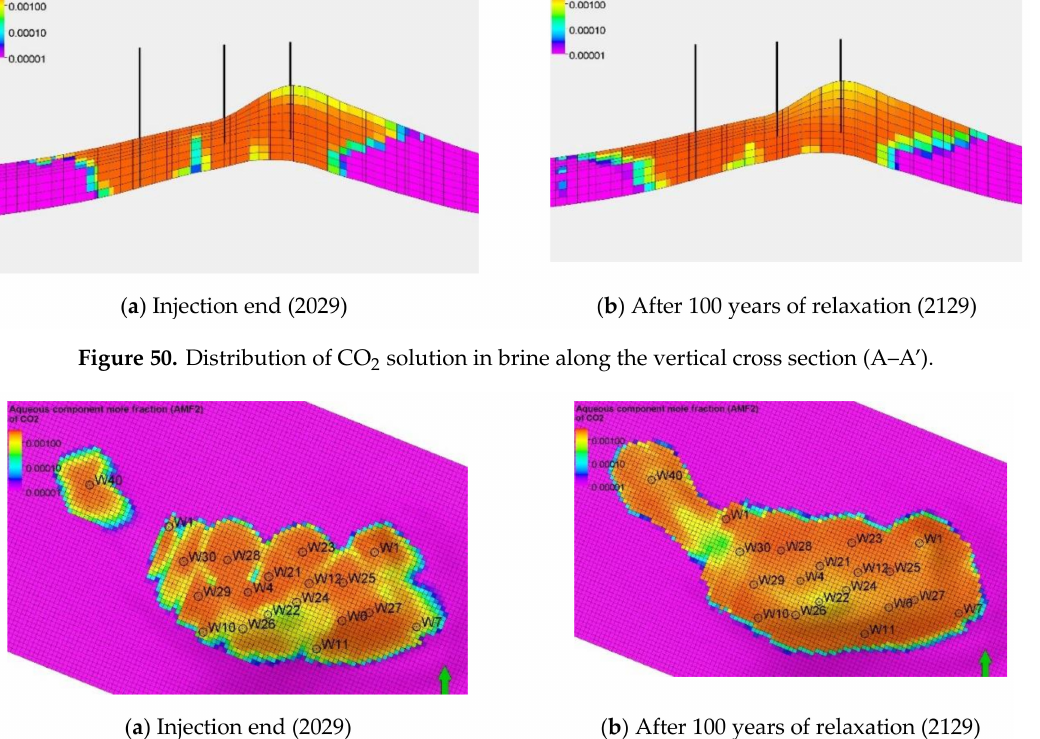
Figure 51. Distribution of CO 2 solution in brine at the structure